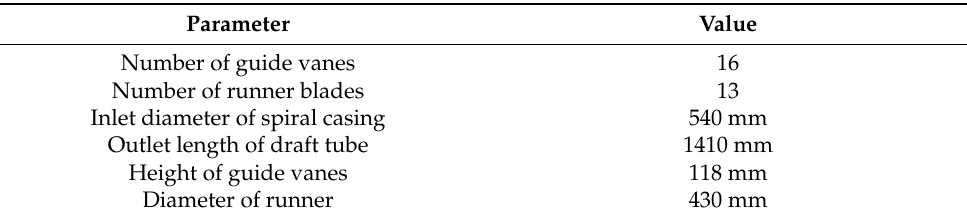
Figure 1. Computational domain of the Francis turbine. ( a ) Whole computing domain for Francis turbine; ( b ) Real view of the prototype Francis turbine; ( c ) Spiral casing; ( d ) Stay/guide vanes; ( e ) Runner blades; ( f ) Draft tube. Table 1. Geometry parameters.